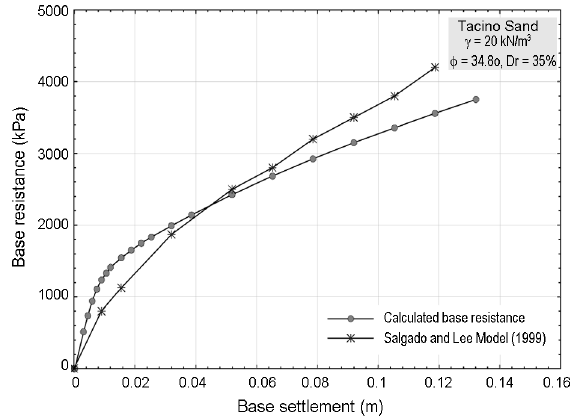
Fig. 4. Calibrated numerical model against Salgado and Lee (1999)